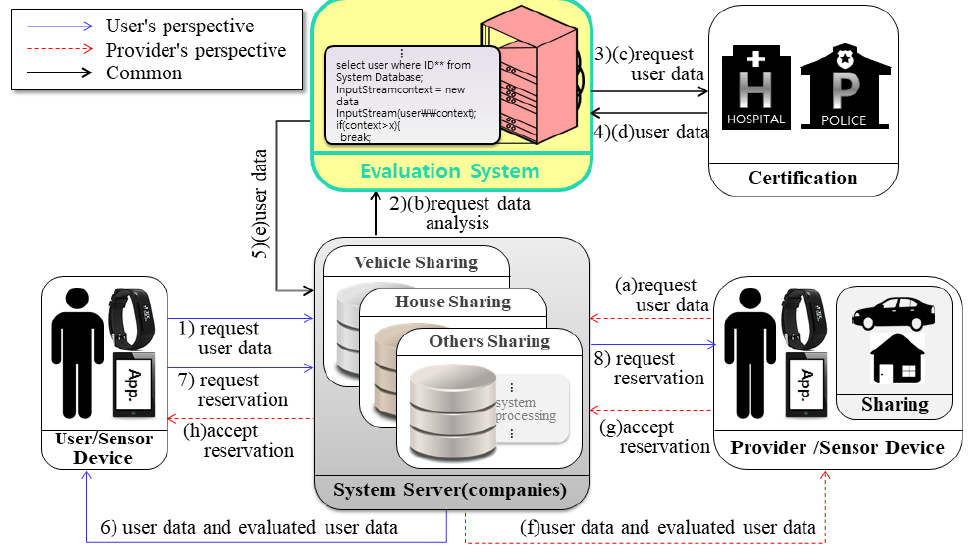
Figure 8. Information analysis flow diagram for providers and users.